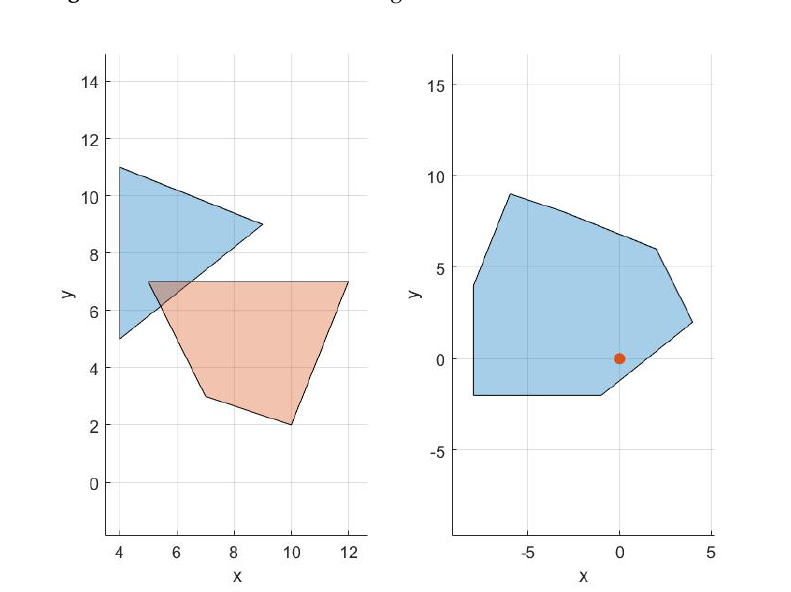
Figure 22. Two intersecting polygons and resulting Minkowski